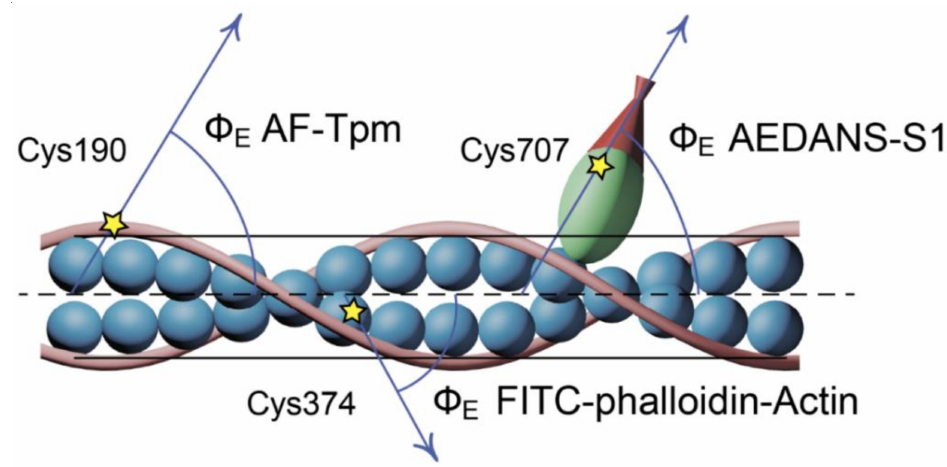
Figure 3. A schematic view of the localization of 5-IAF, FITC-phalloidin, and 1,5-IAEDANS in Tpm, F-actin (Actin), and myosin subfragment-1 (S1), respectively, in the ghost muscle